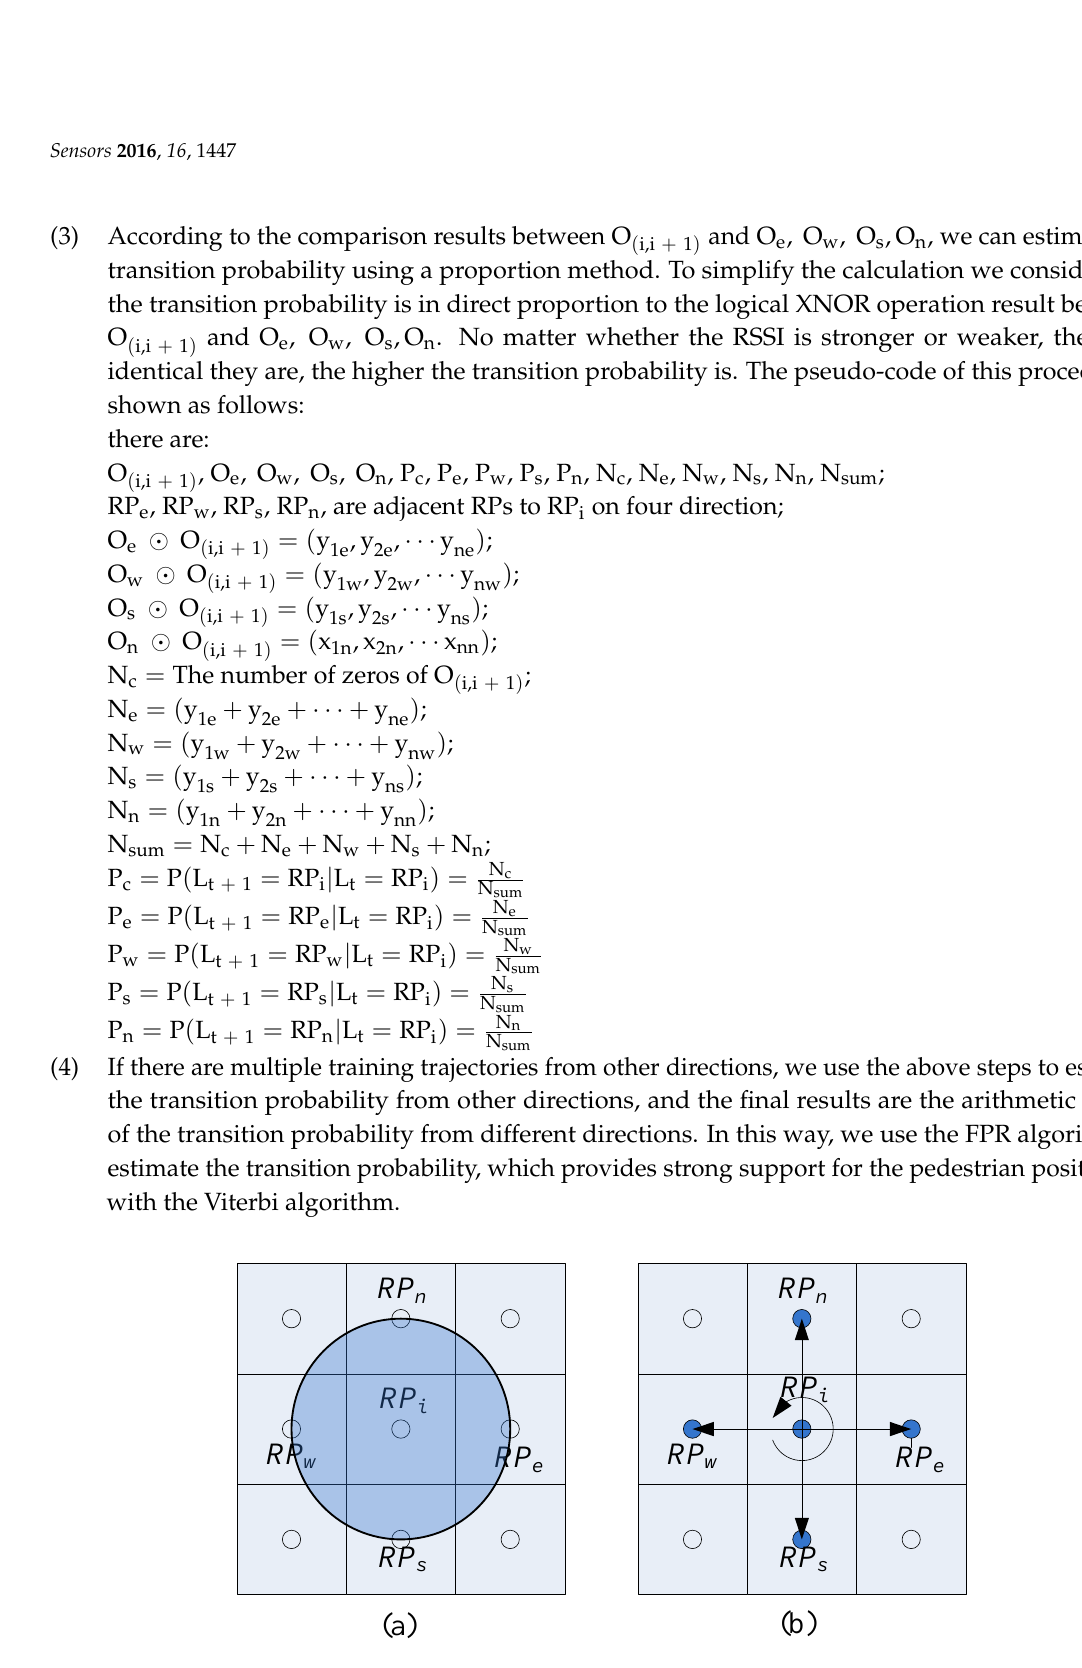
Figure 7. The pedestrian location transition to the next state: ( a ) the possible location after a sampling period; ( b ) consider the adjacent RPs as the possible pedestrian locations.